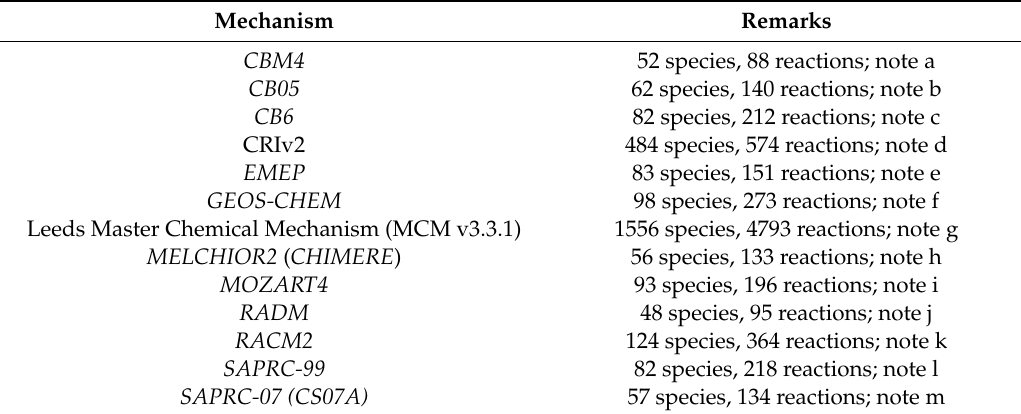
Table 1. Details of the chemical mechanisms implemented in this intercomparison study. Italics are used to signify those mechanisms that have not been implemented as originally developed but have been harmonised and standardised, see text.